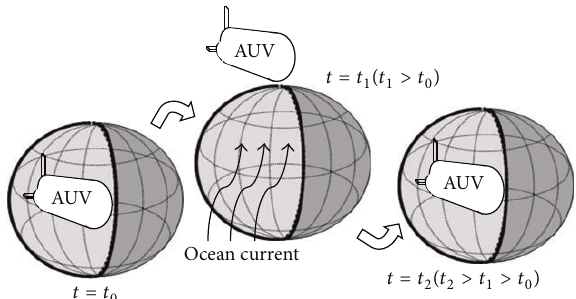
Figure 1: An illustration of an underwater robotic system which performs tracking task in a spherical